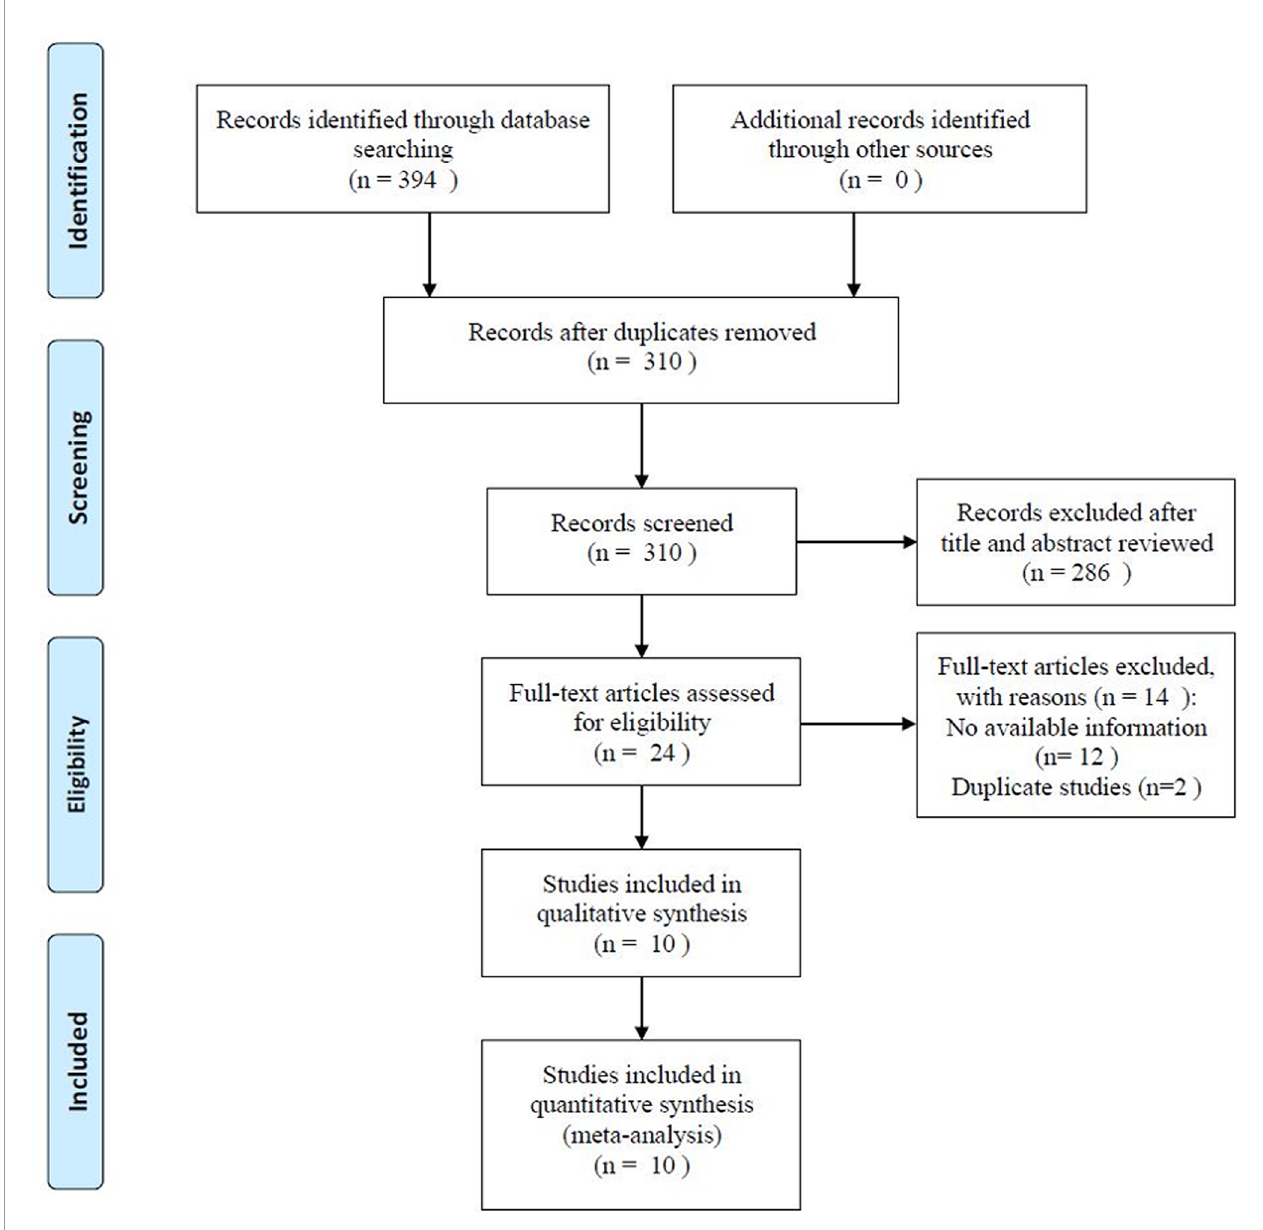
FIGURE 1 | Flow chart of literature